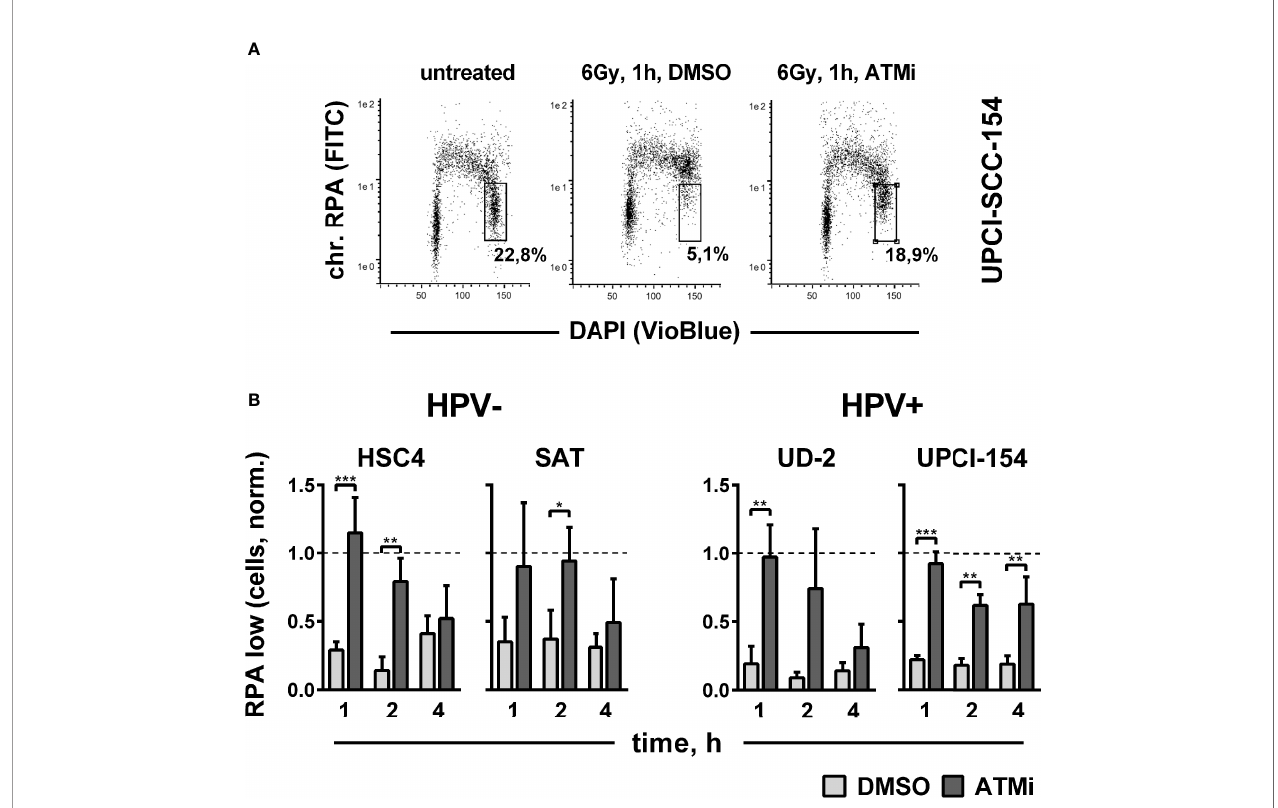
FIGURE 6 | Impact of ATM on radiation-induced DNA end resection. Cells were treated with or without an ATM inhibitor for 30 min before irradiation with 6 Gy. At the indicated time points, cells were pre-extracted before fi xation and fl ow cytometric assessment of chromatin-bound RPA. (A) Gating strategy for G2-phase cells with normal (low) amounts of chromatin-bound RPA. (B) Quanti fi cation of the fraction of G2 phase cells with normal levels of chromatin-bound RPA at the indicated time points after radiation. To reduce variation through differences in the starting fractions of G2-phase cells, values in all individual experiments were normalized to the respective untreated controls harvested at the time of DMSO/ATM inhibitor treatment, which is represented by the dotted line (Y = 1). Asterisks depict signi fi cant differences, with *, **, and *** indicating p < 0.05, p < 0.01, and p < 0.001, respectively (two-tailed Student ’ s